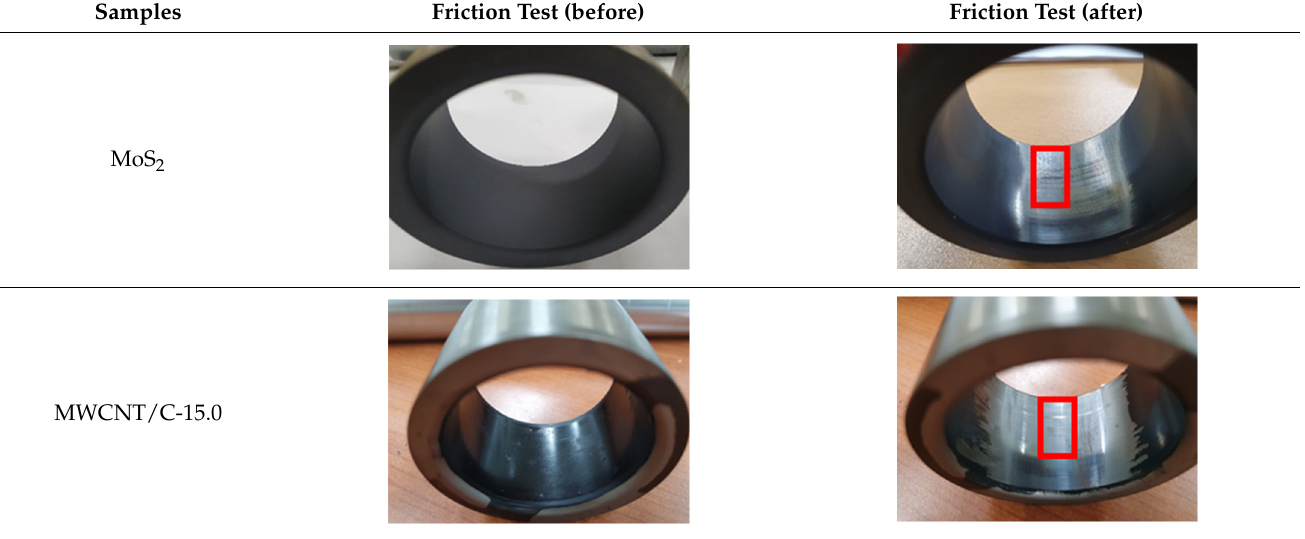
Table 4. Bush wears coated with MoS 2 and MWCNT-based solid lubricants. Samples Friction Test (before) Friction Test (after)